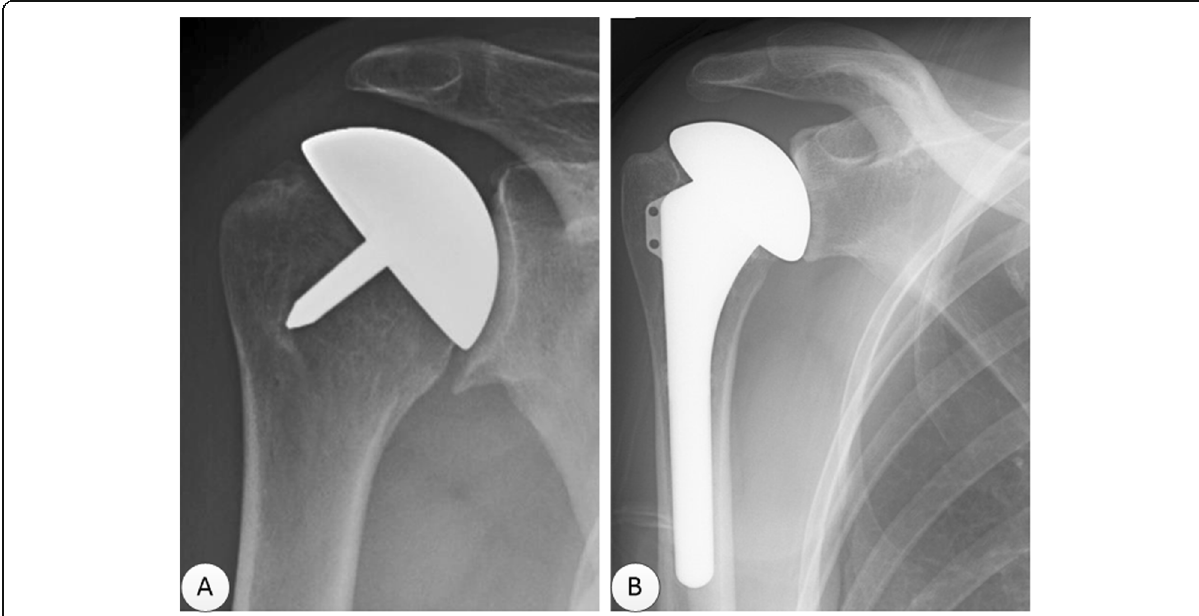
Fig. 1 Anteroposterior radiographs (postoperation) for the treatment of GHOA. a resurfacing hemiarthroplasty (RHA); b stemmed hemiarthroplasty